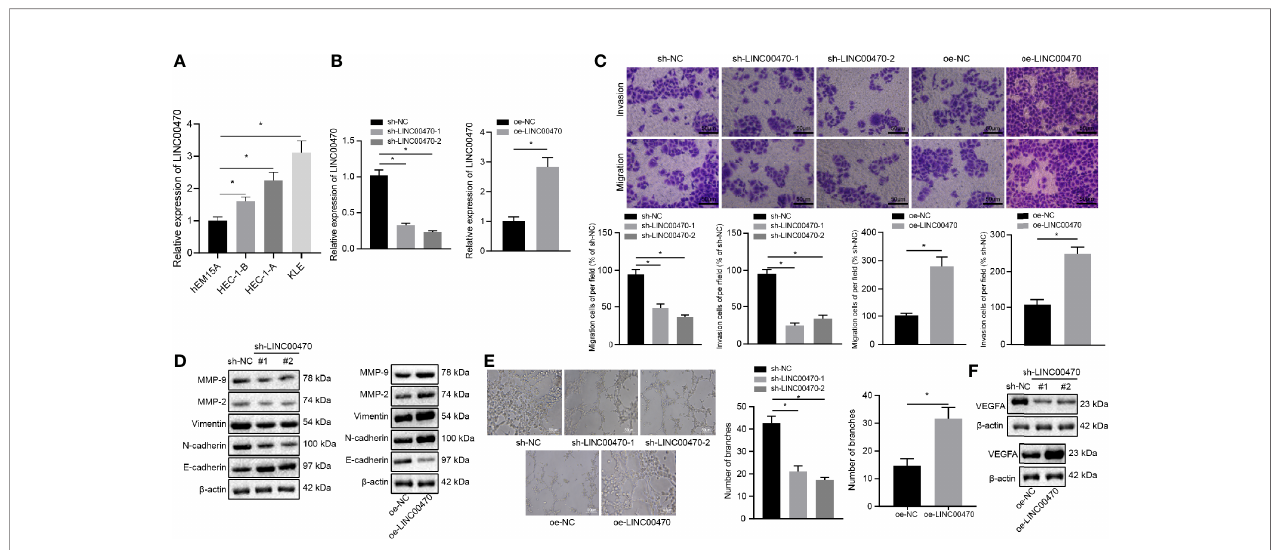
FIGURE 2 | Silencing LINC00470 inhibited the invasion/migration potentials and angiogenesis of EC cells. (A) RT-qPCR determination of the expression of LINC00470 in immortalized endometrial stromal cell line epithelial cell line hEM15A, and HEC-1-B, HEC-1-A, and KLE cells. KLE cells with the highest expression of LINC00470 were selected for subsequent loss-of-function experiments and LINC00470 was silenced in KLE cells while HEC-1-B cells with lowest expression of LINC00470 were selected for gain-of-function experiments and LINC00470 was overexpressed in HEC-1-B cells. (B) RT-qPCR determination of the expression of LINC00470 in the KLE cells after LINC00470 knockdown and in HEC-1-B cells after LINC00470 overexpression. (C) Changes in migration and invasion ability assessed by Transwell in the KLE cells after LINC00470 knockdown and in HEC-1-B cells after LINC00470 overexpression, scale bar = 50 m m. (D) Western blot analysis of the expression of Vimentin, E-cadherin, N- cadherin, MMP-9, and MMP-2 in the KLE cells after LINC00470 knockdown and in HEC-1-B cells after LINC00470 overexpression normalized to b -actin. (E) The tube formation ability of the cells assessed by tube formation experiment after LINC00470 knockdown or overexpression, scale bar = 50 m m. (F) Western blot analysis of VEGFA expression in the KLE cells after LINC00470 knockdown and in HEC-1-B cells after LINC00470 overexpression normalized to b -actin. The experimental data were expressed as mean ± standard deviation, and data comparison between multiple groups were conducted with one-way ANOVA and Tukey ’ s post hoc test, * p <